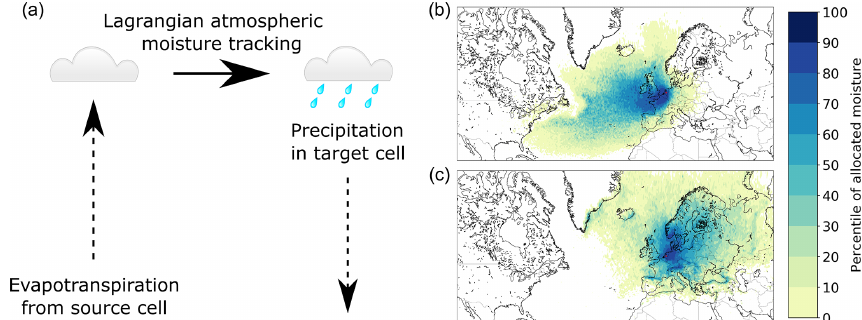
Figure 1. The UTrack atmospheric moisture tracking model. (a) The model tracks evaporation through the atmosphere from source cells to target cells using a Lagrangian moisture tracking scheme forced with ERA5 reanalysis data. (b) An example of an “evaporation footprint”, or “evaporation shed”, from the UTrack model. (c) An example of a “precipitation footprint”, or “precipitation shed”. The examples show the distribution of reprecipitation for evaporated water from Utrecht (the Netherlands) during 2008–2017 (b) and the distribution of the city’s source of precipitation (c) , given as percentages of allocated